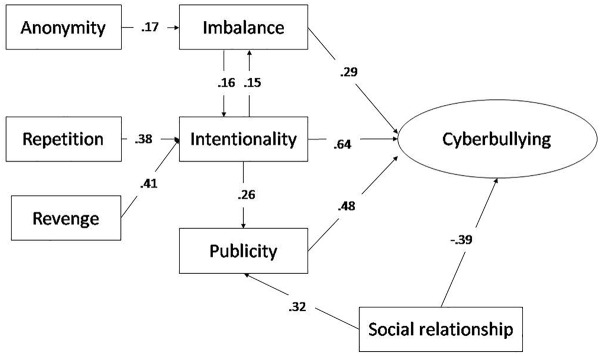
Structural equation model of the cyberbullying victim.